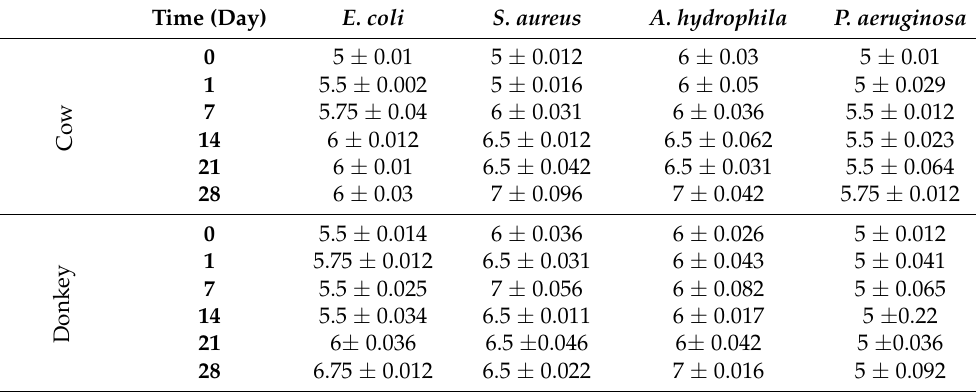
Table 4. Average zone diameter for antibacterial activity of cow and donkey kefirs during storage time at 4 ◦